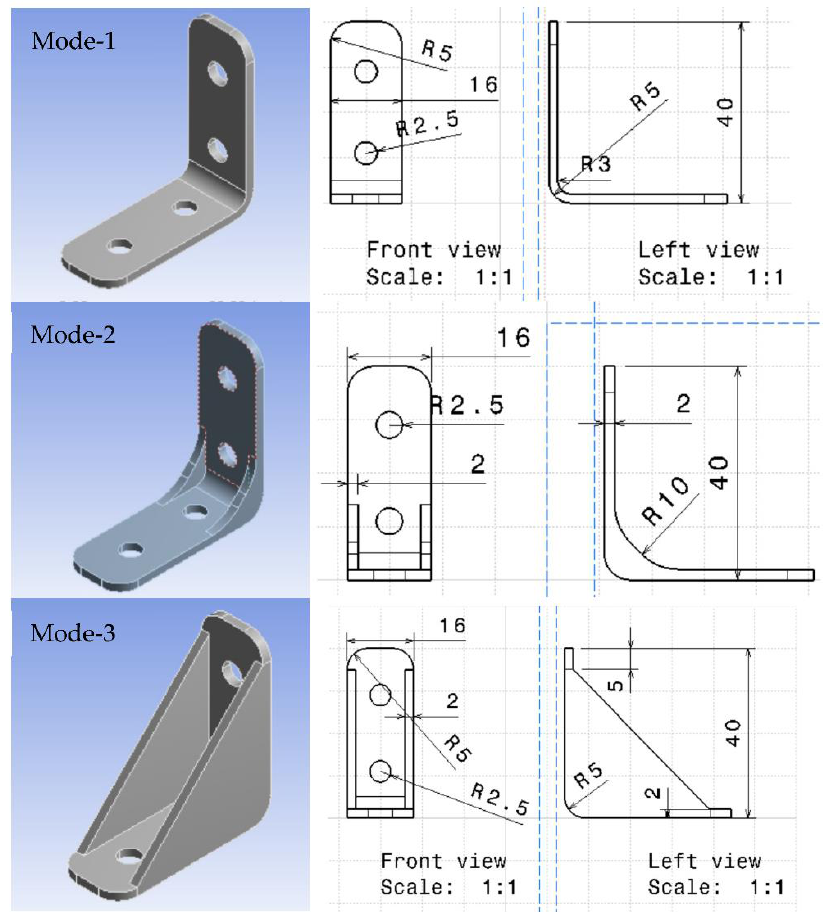
Figure 1. Different CAD models of brackets were developed for comparison.